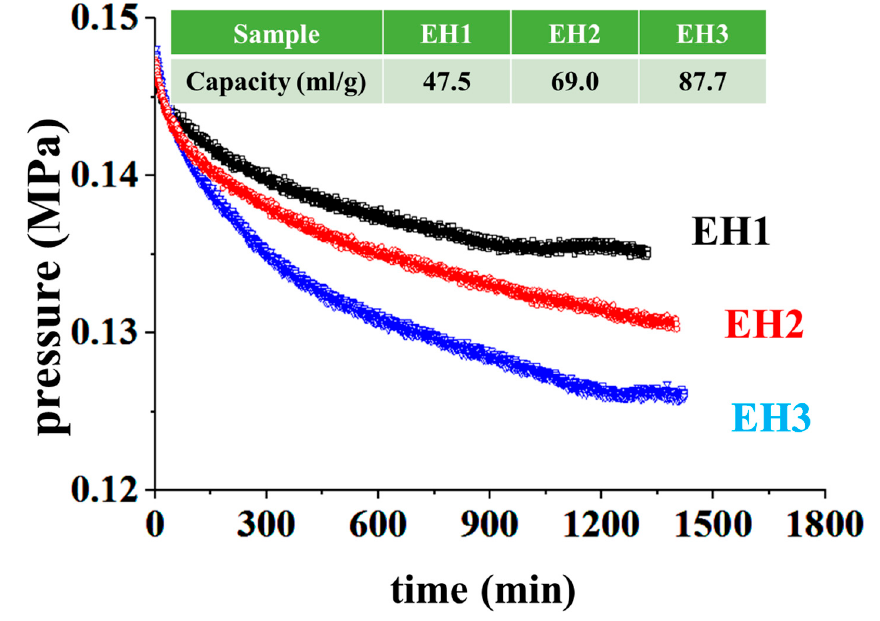
Figure 4. H 2 pressure vs. time plot for EH x at 298 K and an initial pressure of 200 KPa. Inset shows the capacity of samples EH1-EH3 .